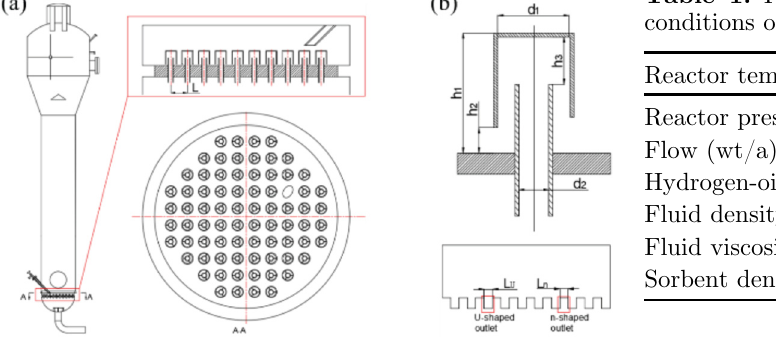
Fig. 2. (a) Structural schematic of the distribution disc; (b) bubble cap unit and bubble cap expansion diagram.